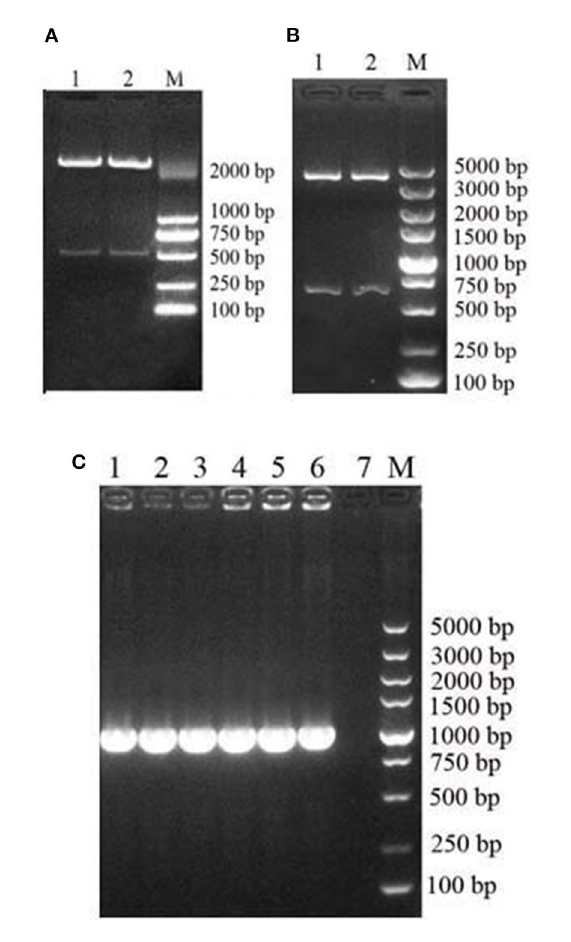
FIGURE1 Construction and identification of an MiIFN- α recombinant yeast expression vector. (A) Digestion of pUC57-MiIFN- α recombinant plasmid with Eco R I and Xba I. (B) Identification of pPICZ α -MiIFN- α recombinant plasmid by restriction enzyme digestion with Eco R I and Xba I. (C) PCR identification of pPICZ α -MiIFN- α